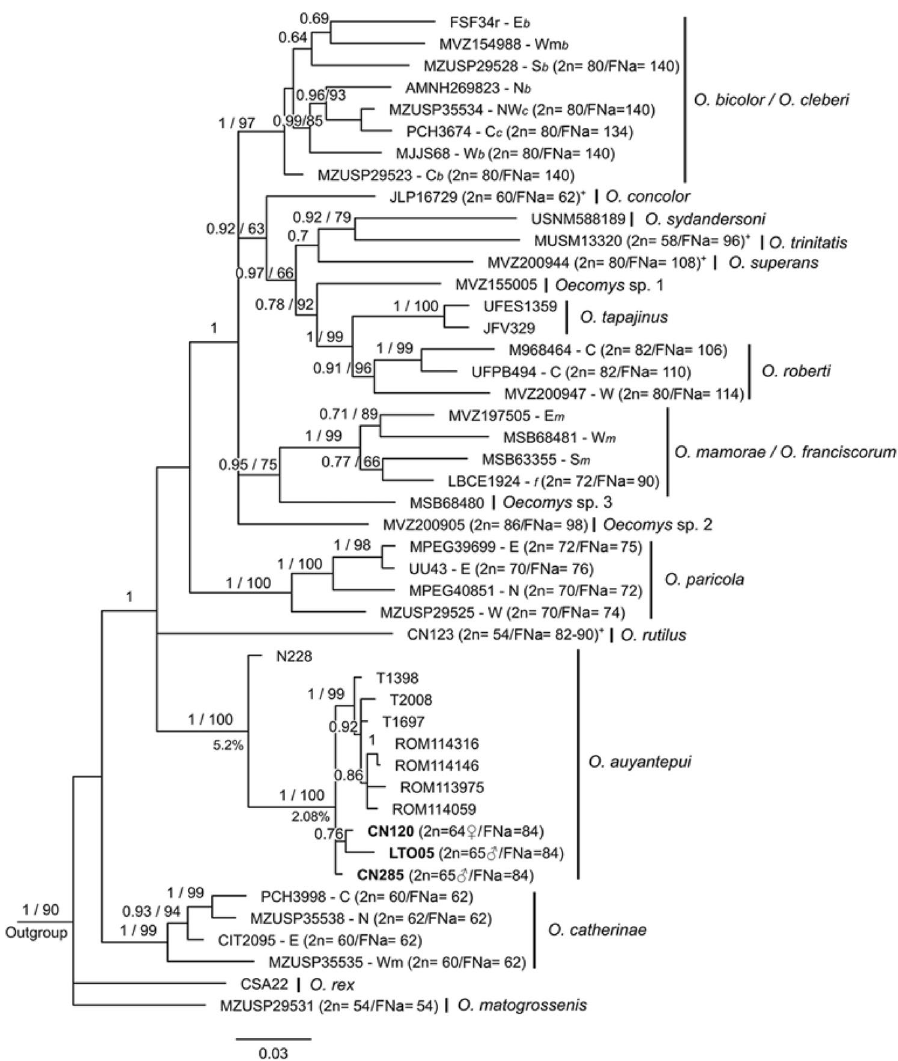
Figure 5. Bayesian Inference topology based on Cytochrome b. The numbers above branches indicate posterior probability values for Bayesian Inference analysis (only values > 0.60 are shown) and bootstrap values for Maximum Likelihood analysis (only values > 60% are shown). Bold numbers indicate the samples from this study. Percentage values are mean genetic distances (p-distances) between high supported selected lineages of O. auyantepui . Representatives of different lineages within O. bicolor , O. cleberi , O. roberti , O. mamorae , O. paricola , and O. catherinae complexes are indicated by the letters C (central clade), E (eastern clade), N (northern clade), NW (northwestern clade), S (southern clade), W (western clade), and Wm (westernmost clade), following 48 . Subscribed letters b and c indicate lineages attributed by 48 to O. bicolor and O. cleberi , respectively.